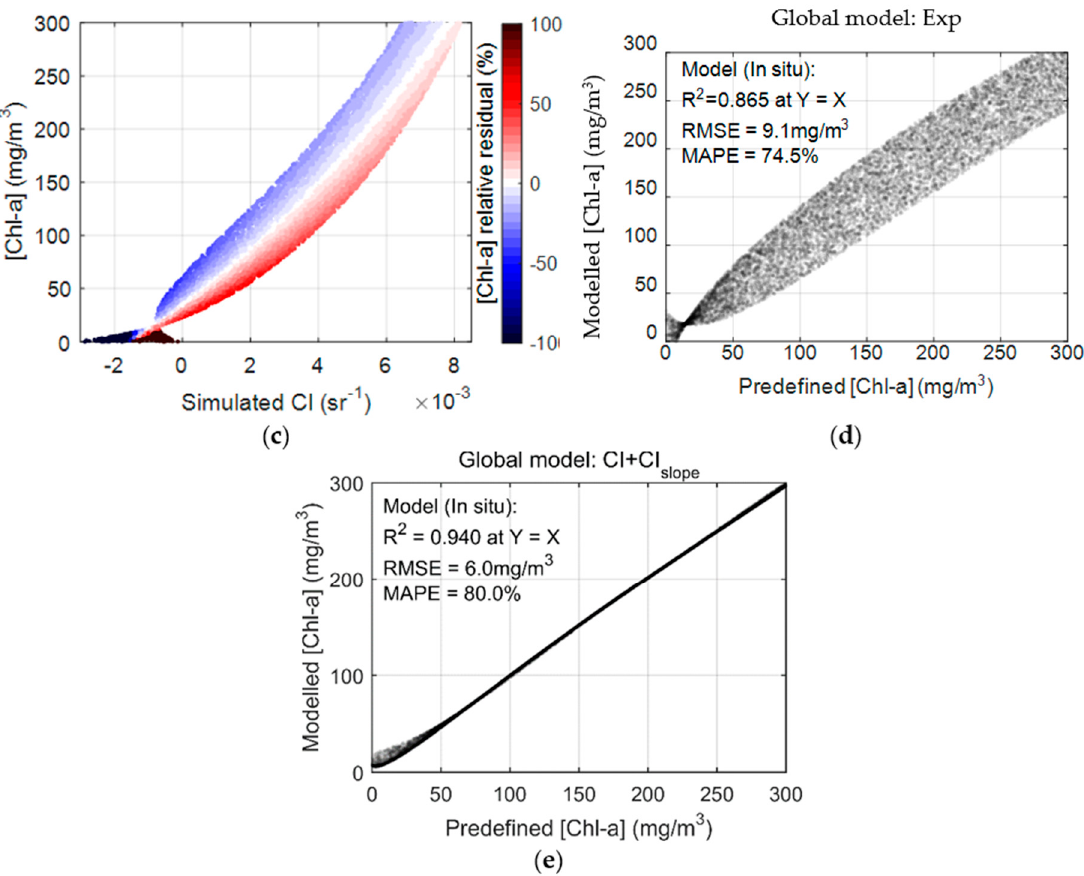
Figure 9. ( a ) Comparison of in situ and Ecolight simulated CI, ( b ) modeled variability of the CI:[Chl-a] relationship in response to MSPM, ( c ) the distribution of MAPE residual when applying an exponential CI:[Chl-a]best-fitmodel, ( d )modeledandinsitu[Chl-a]fromaglobalbest-fitregression, and( e )modeled [Chl-a] from combined CI and CI slope